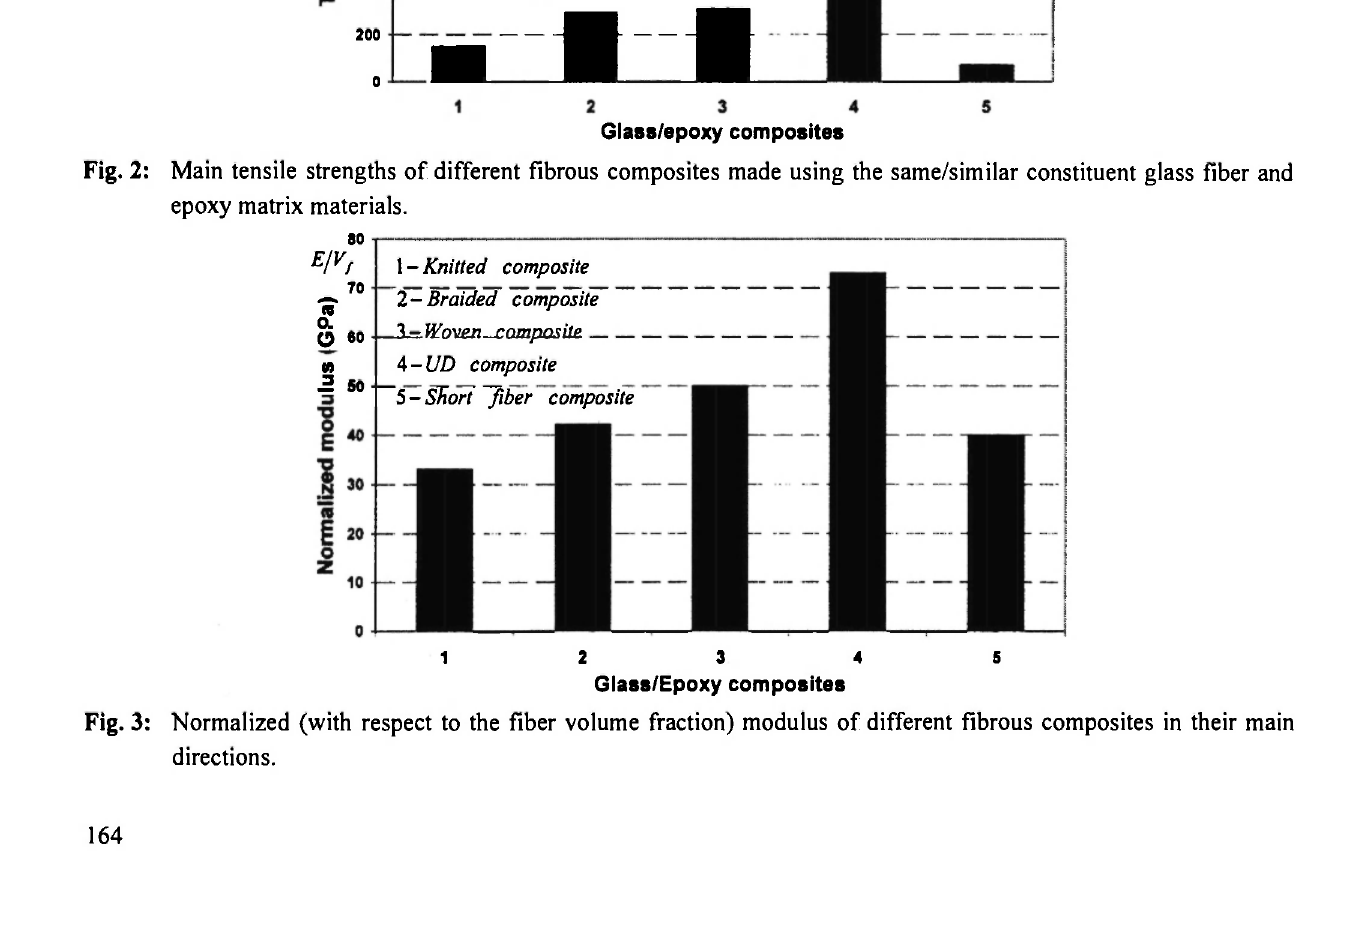
Fig. 1: Main moduli of different fibrous composites made using the same/ similar constituent glass fiber and epoxy matrix materials.